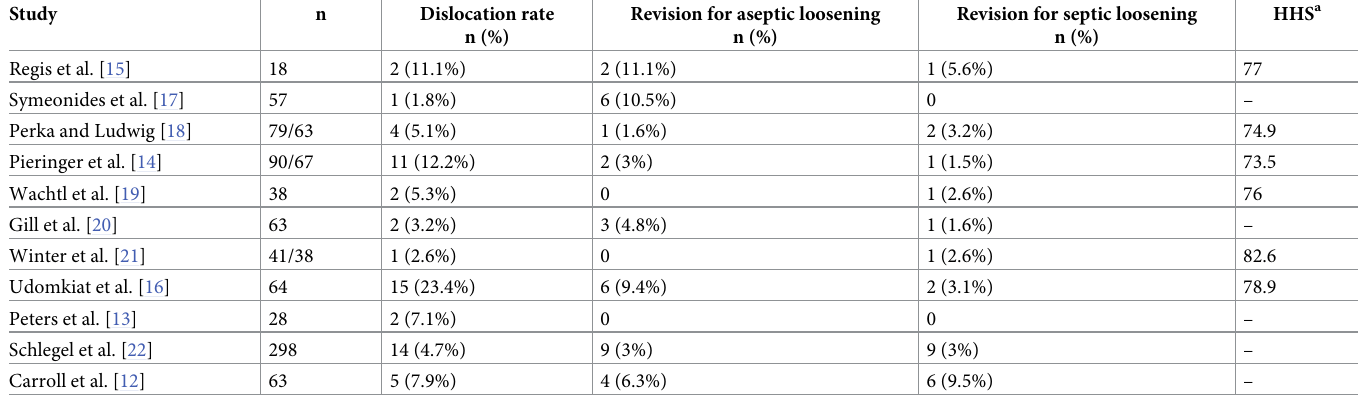
Table 1. Studies reporting on cemented polyethylene cups in combination with